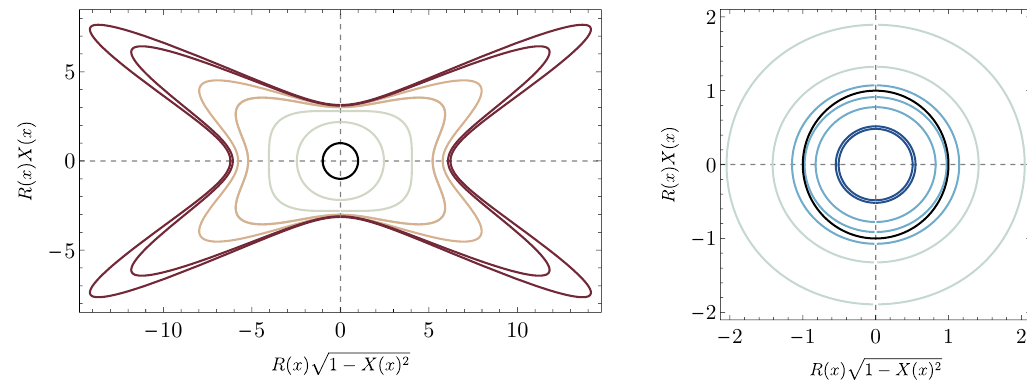
Figure 4 . Hyperbolic embedding of the cross section of the black hole solution horizons, for several values of the parameter " and a (cid:12)xed low temperature T = 0 : 2506. In this regime, there is a four- fold black hole non-uniqueness. Left : embeddings for the upper, thermodynamically dominant branch of solutions with " 2 (1 : 520 ; 2 : 059), and the largest entropy branch (two outer curves in red, " = 2 : 055 ; 2 : 05). The black circle is the T = 1 =(cid:25) , " = 0 black hole. Right : embeddings for the two small black hole branches. The higher entropy branch has " 2 (1 : 520 ; 2 : 557), and the two inner circles in dark blue represent the lowest branch ( " = 2 : 55 ; 2 : 53). The embeddings are qualitatively similar for the low T